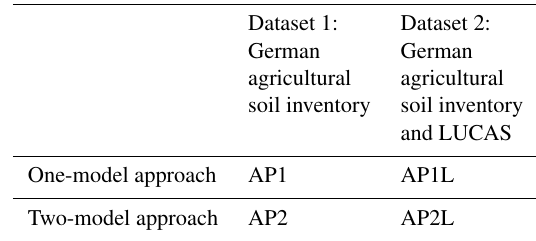
Table 1. Modelling